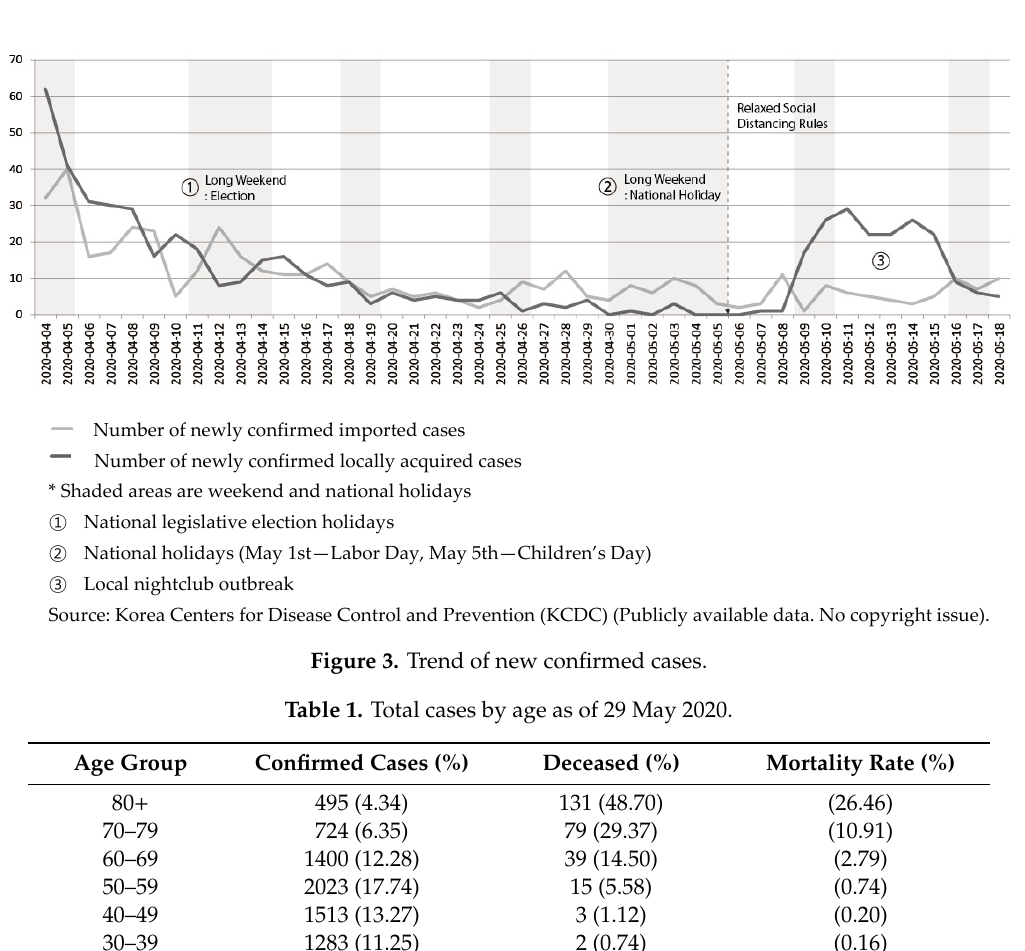
Figure 2. Cumulative number of deaths by SARS-CoV-2 in South Korea.